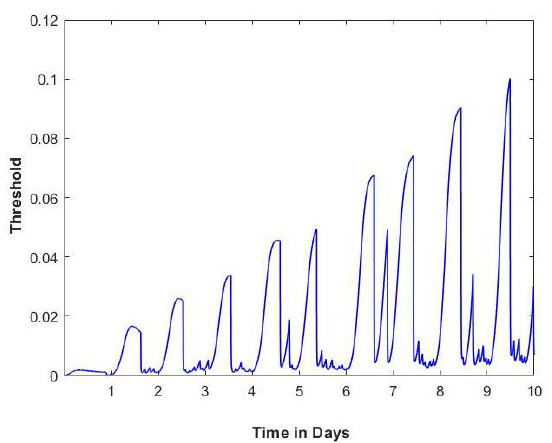
Figure 7. Example of 10 days calculated threshold value using the control theory model of smoking and collected data from one of the participants [2].